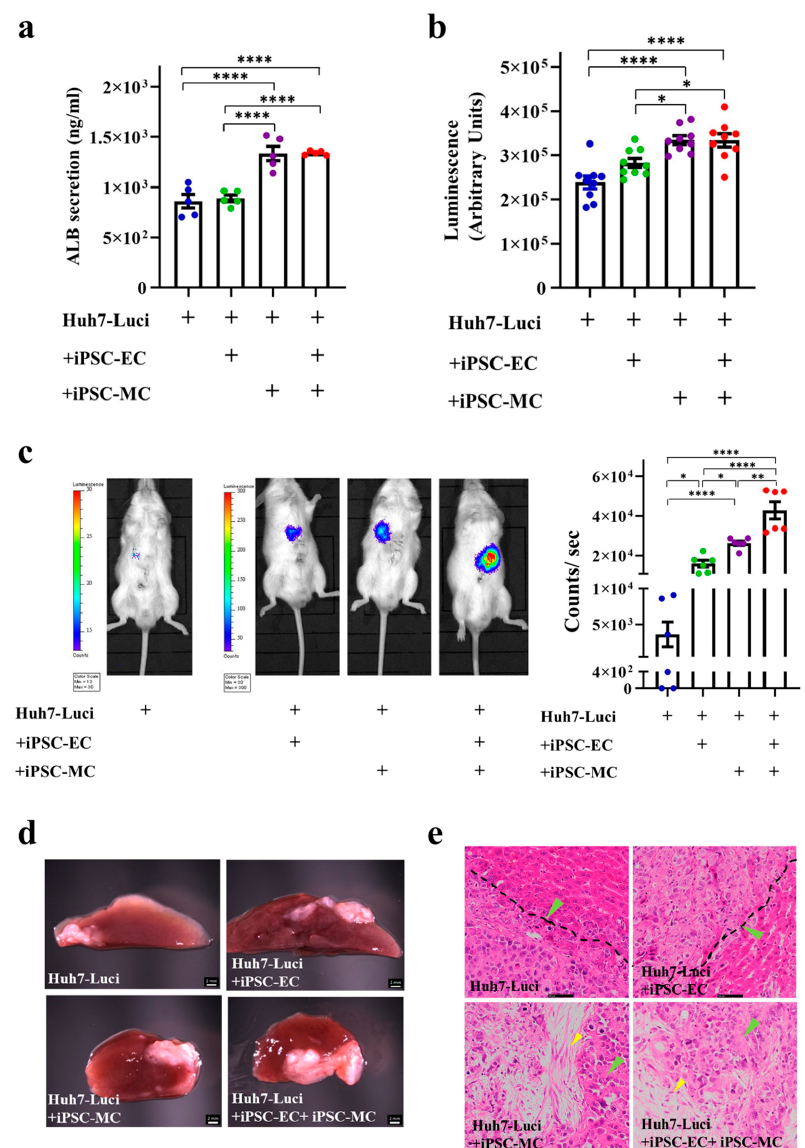
Figure 3. Liver cancer organoid can separate into four groups in vitro and in vivo. ( a ) Albumin (ALB) secretion of Huh7-Luci, Huh7-Luci + iPSC-EC, Huh7-Luci + iPSC-MC, and Huh7-Luci + iPSC-EC + iPSC-MC organoid at day 6. One-way ANOVA followed by Tukey’s multiple comparisons test ( n = 5/group). ( b ) Bioluminescence intensities of luciferase activity in Huh7-Luci, Huh7-Luci + iPSC-EC, Huh7-Luci + iPSC-MC, Huh7-Luci + iPSC-EC + iPSC-MC group at day 6 in vitro. One-way ANOVA followed by Tukey’s multiple comparisons test ( n = 9/group). ( c ) BLI of luciferase activity in mice implanted with different liver cancer organoid groups in vivo. Left to right: Huh7-Luci, Huh7-Luci + iPSC-EC, Huh7-Luci + iPSC-MC, Huh7-Luci + iPSC-EC + iPSC-MC show pseudo color images of bioluminescent signals from the liver. Acquisition times were set as 1 min at a binning of 100 pixels. Relative light units/pixels are indicated in the color scale bar. One-way ANOVA followed by Tukey’s multiple comparisons test ( n = 6/group). ( d ) Morphology analysis of organoids composed of Huh7-Luci, Huh7-Luci + iPSC-EC, Huh7-Luci + iPSC-MC, Huh7-Luci + iPSC-EC + iPSC-MC that were implanted onto the liver surface, followed by UPAL gel capping. The scale bar represents 2 mm. ( e ) HE staining of mice liver after 2 weeks of different liver cancer organoid implantation. The black dotted line indicates the junction of normal liver tissue and tumor tissue. Green arrows indicate tumor cells; yellow arrows indicate iPSC-MC. The scale bar represents 50 µ m. * p < 0.05, ** p < 0.01, **** p <